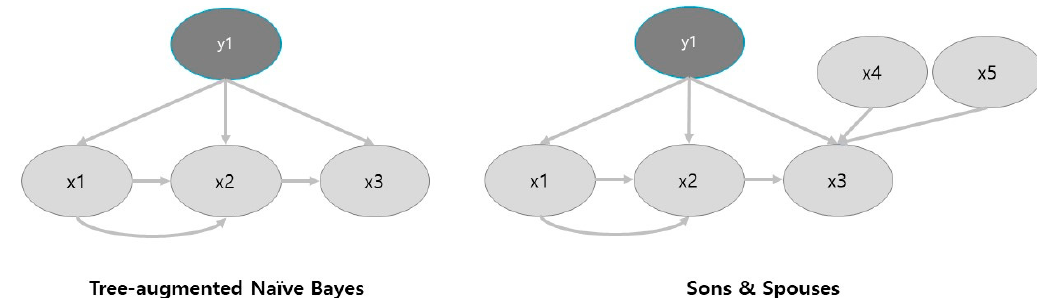
Figure 1. The main difference between the Tree Augmented Naïve Bayes model and the Sons and Spouses model. As can be seen, the Sons and Spouses model allows for relationships that are not directly linked to the target (father) node.